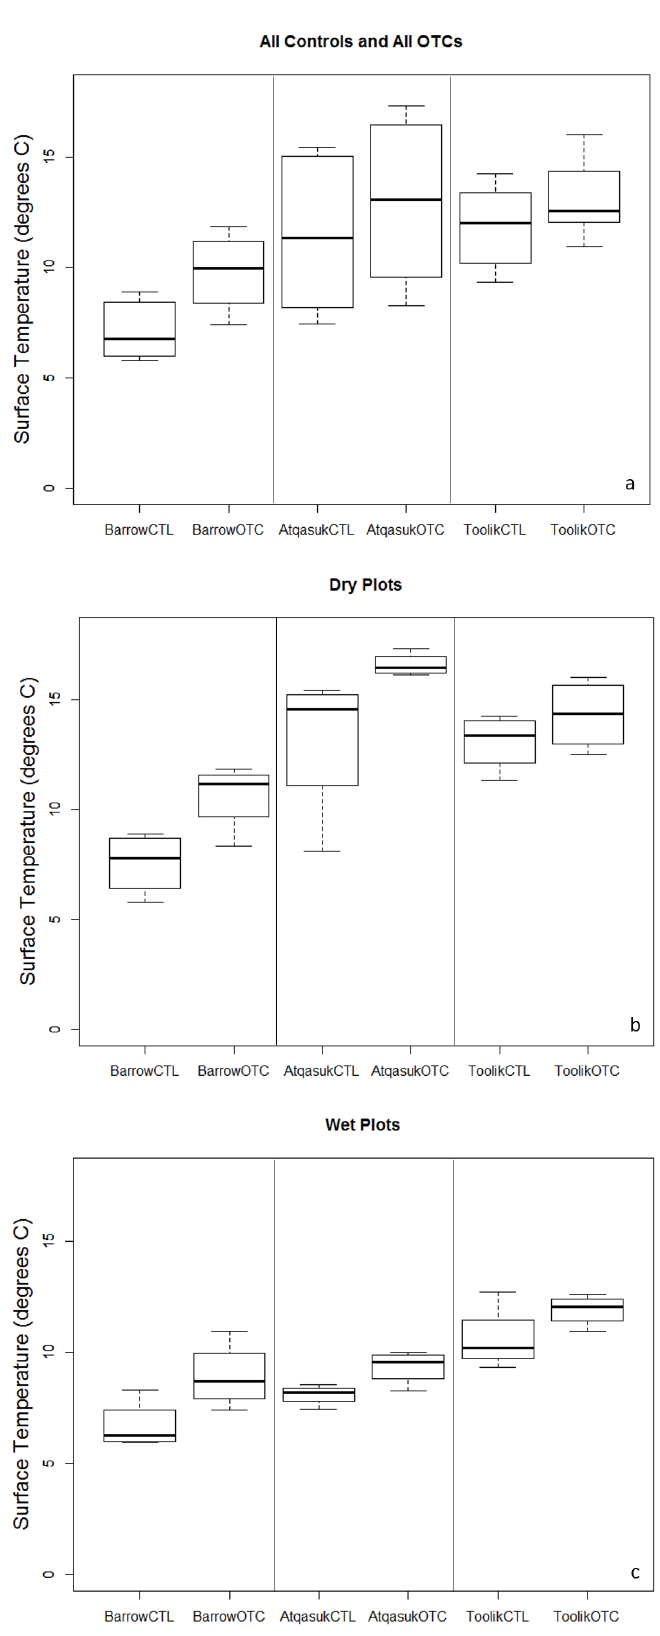
Figure 10. Boxplots of the plot-level average surface temperature data for all controls (CTL) and all Open Top Chambers (OTC) ( a ); all dry plots ( b ); and all wet/moist plots ( c